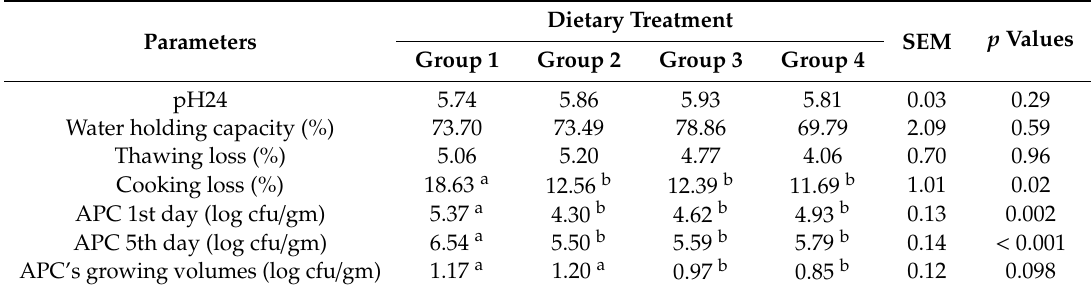
Table 8. Meat quality parameters in breast muscle of broilers chickens fed di ff erent species of microalgae for 32